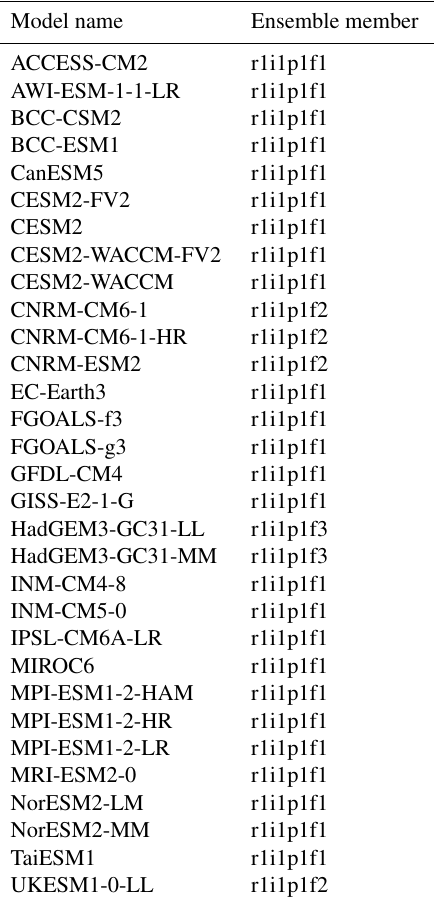
Table B1. CMIP6 models used in this paper.